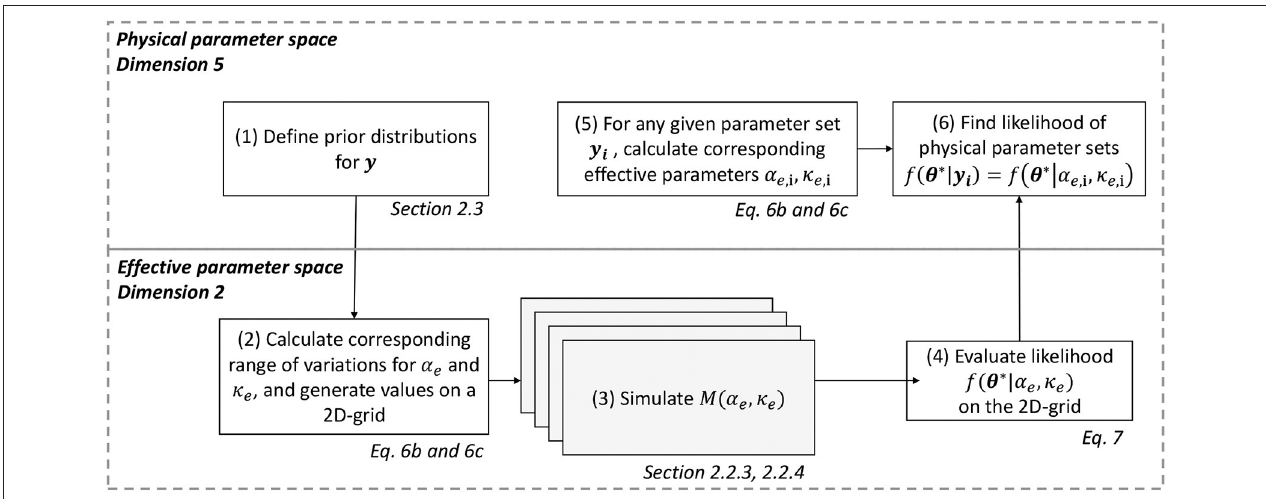
FIGURE 2 | Calculation of the likelihood function f 2 ( θ ∗ | y ) with the dimensionality reduction. The computational burden resides in the computation of model outputs M in step 3. Computing model outputs in the effective parameter space reduces the computational burden by going from a parameter space with dimension 5 [ O ( N 5 ) simulations] to 2 [ O ( N 2 ) simulations].